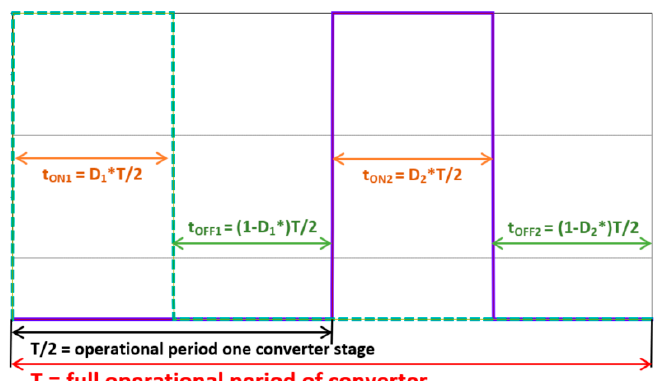
Figure 3. Proposed dual interleaved boost converter with coupled inductors and demagnetizing circuit.